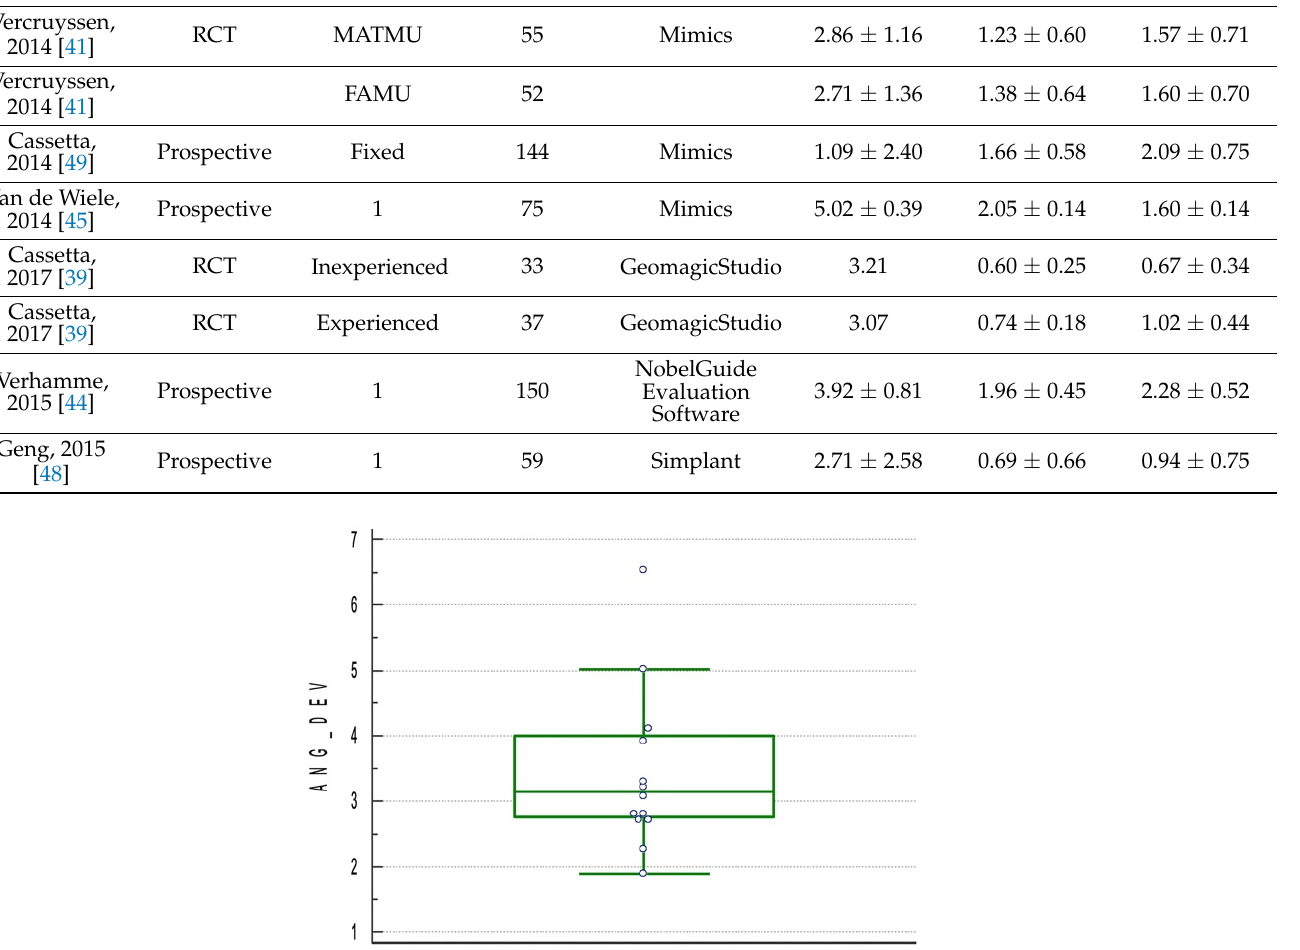
Figure 5. Boxplot for angular deviation of the included studies.